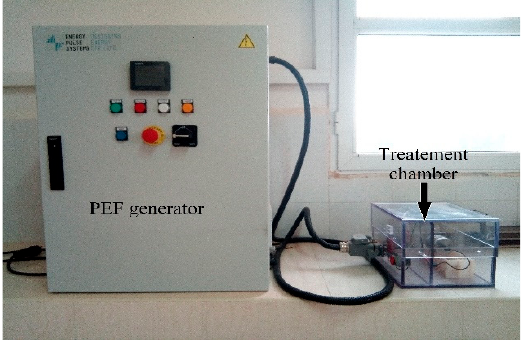
Figure 1. A photograph of the PEF generator and the treatment chamber.